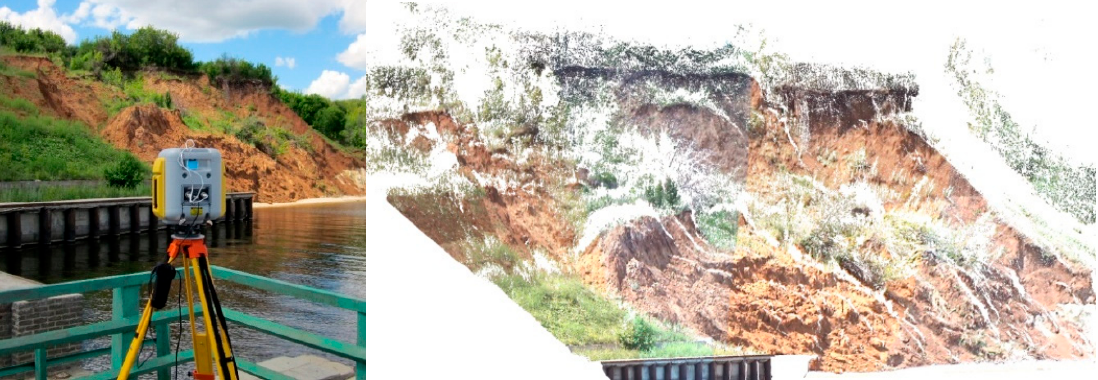
Figure 5. Used scanning equipment—Trimble GX and point clouds for Site 1 (2014). Table 1. Number (#) of laser scanning points at Site